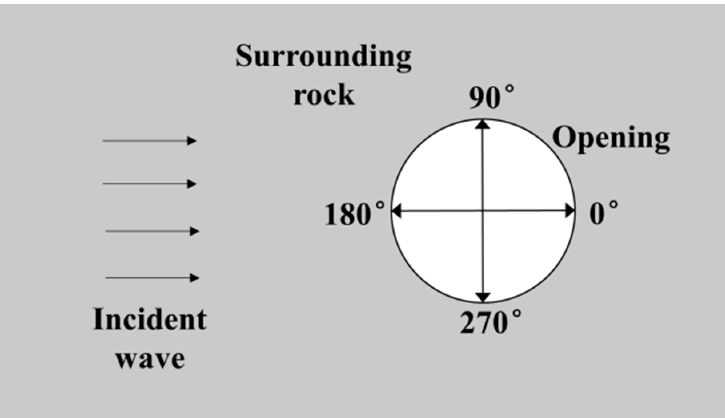
Figure 3. Schematic of incident stress wave.